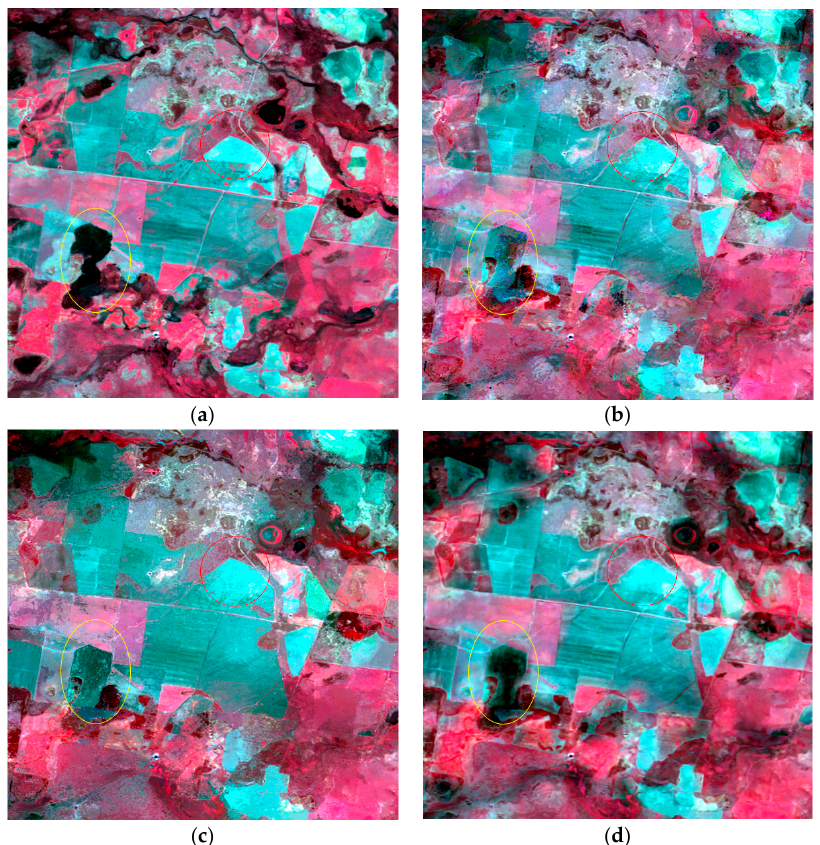
Figure 7. Comparison of the fusion results from the STARFM, FSDAF and RWSTFM methods for the second dataset: NIR-red-green composites of ( a ) the original Landsat image from 28 December 2004; ( b ) the predicted image using the STARFM; ( c ) the predicted image using the FSDAF; and ( d ) the predicted image using the RWSTFM. Table 3. The fusion results from the STARFM, FSDAF and RWSTFM methods evaluated using objective indices for the second dataset.